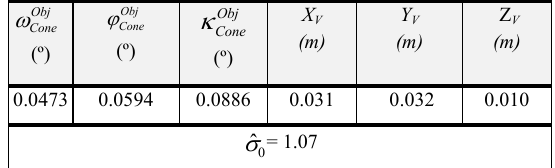
Figure 4: Residuals with radial distance for: a) RFM with 3rd order polynomials; b) RFM with 4rd order polynomials; c) Adjustment with φ -r polynomials.